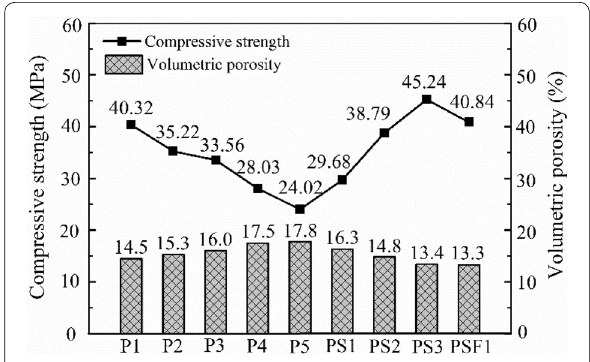
Fig. 8 Comparison of the compressive strength and volumetric porosity of pervious concrete